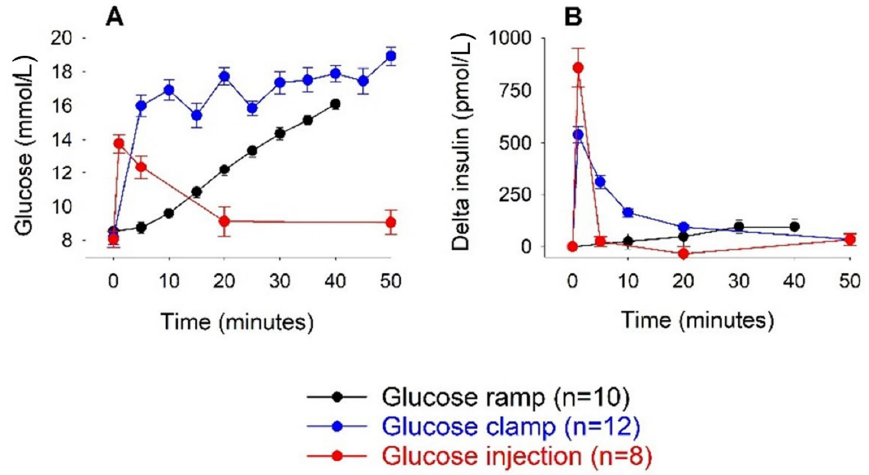
Figure 4. Glucose levels ( A ) and increase in insulin levels (delta insulin) ( B ) during hyperglycaemic clamp (data from [26]), glucose ramp (data from [27]), and intravenous glucose (at 0.35 g/kg) (data from present study) in C57BL/6J mice. Means ± SEM are shown.